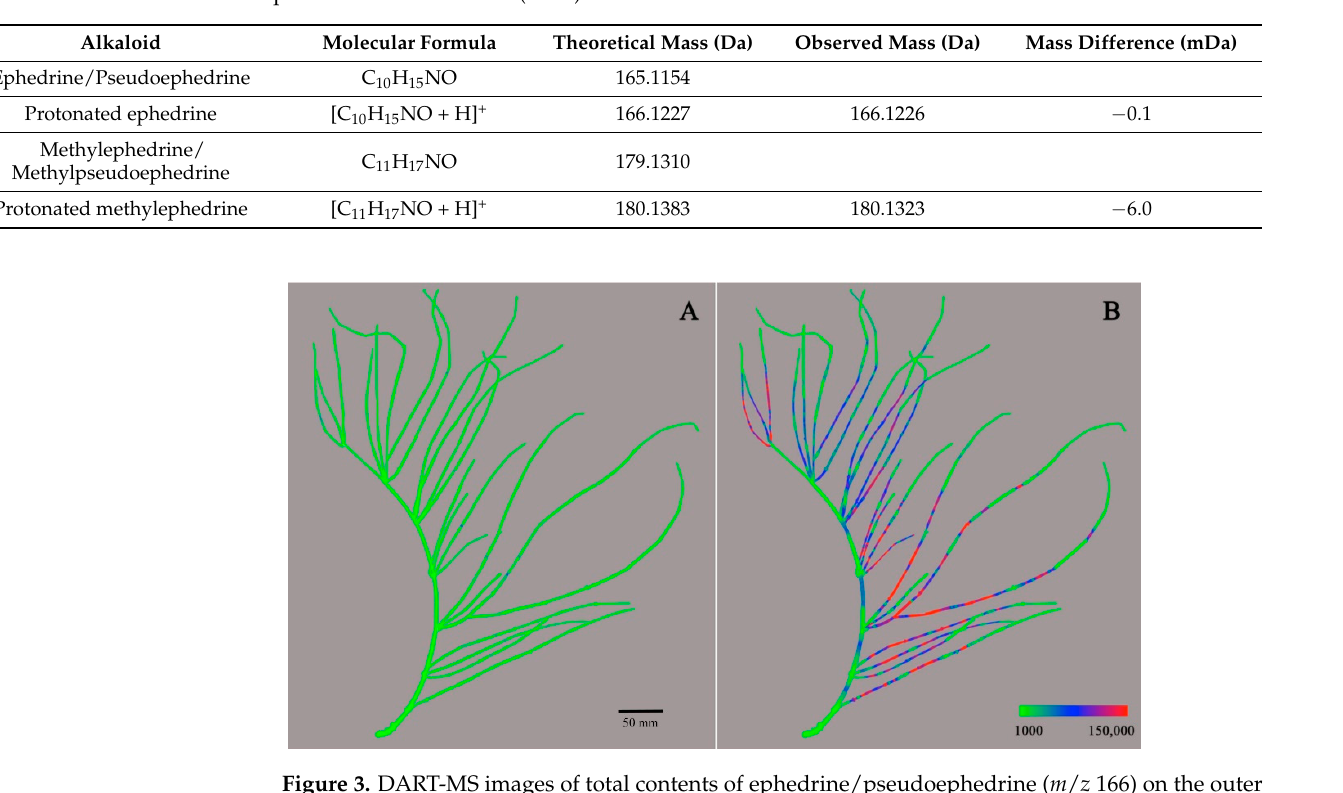
Table 1. Molecular formula, theoretical mass, and observed mass of major ephedra alkaloids and their protonated molecules. The mass difference was represented as millidalton (mDa).